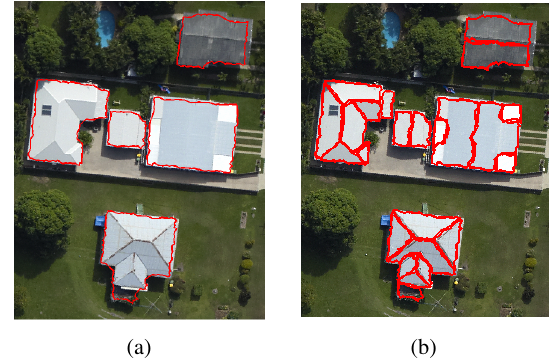
Figure 7: (a): Detected building boundary; (b): extracted planar segments for a data set.